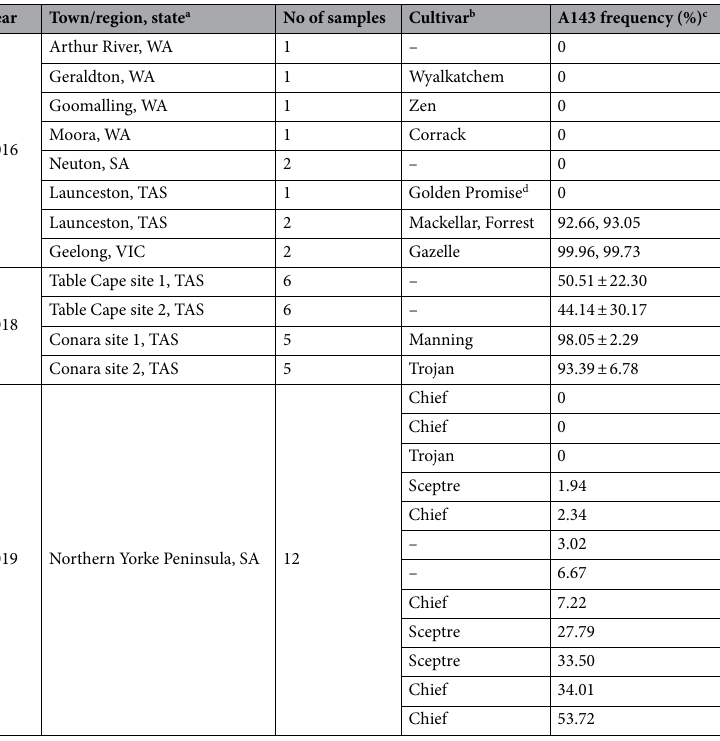
Table 1. Sample details and cytb A143 allele frequency of Blumeria graminis f. sp. tritici from infected wheat collected in this study. a WA Western Australia, SA South Australia, TAS Tasmania, VIC Victoria. b Unknown cultivars are denoted as –. c All values as per dPCR analysis except the 2019 samples which are from ASqPCR. For 2018 samples, the values represent averages (± s.d.) per site. d Barley sample.